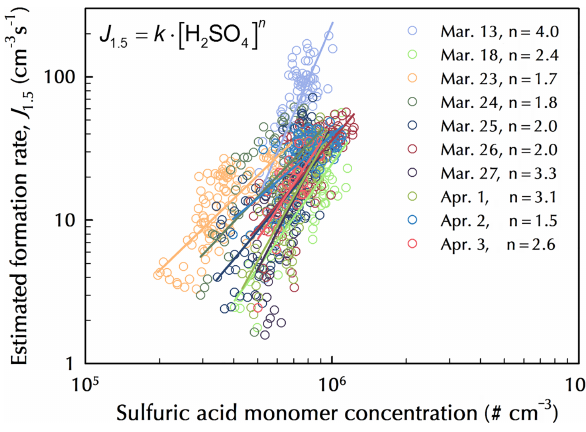
Figure 3. The correlations between the estimated new particle for- mation rate, J 1 . 5 , and the sulfuric acid concentration during the NPF event period on each NPF day. The regression line of J 1 . 5 versus the sulfuric acid concentration was exponentially fitted. n is the expo- nent. Data on 29 March were not included because the correlation was not significant ( p = 0 .